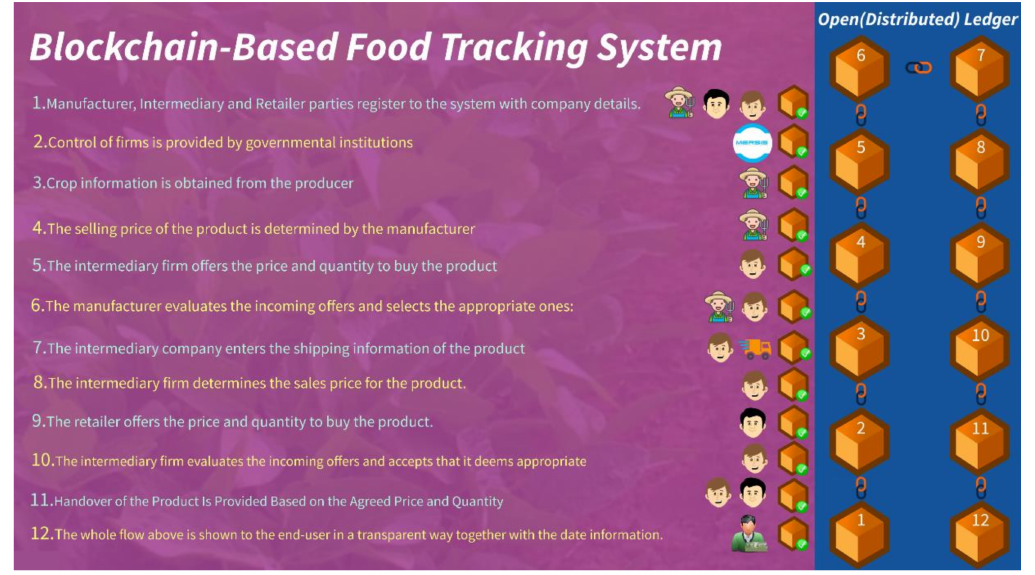
Figure 3. Workflow of the proposed system.